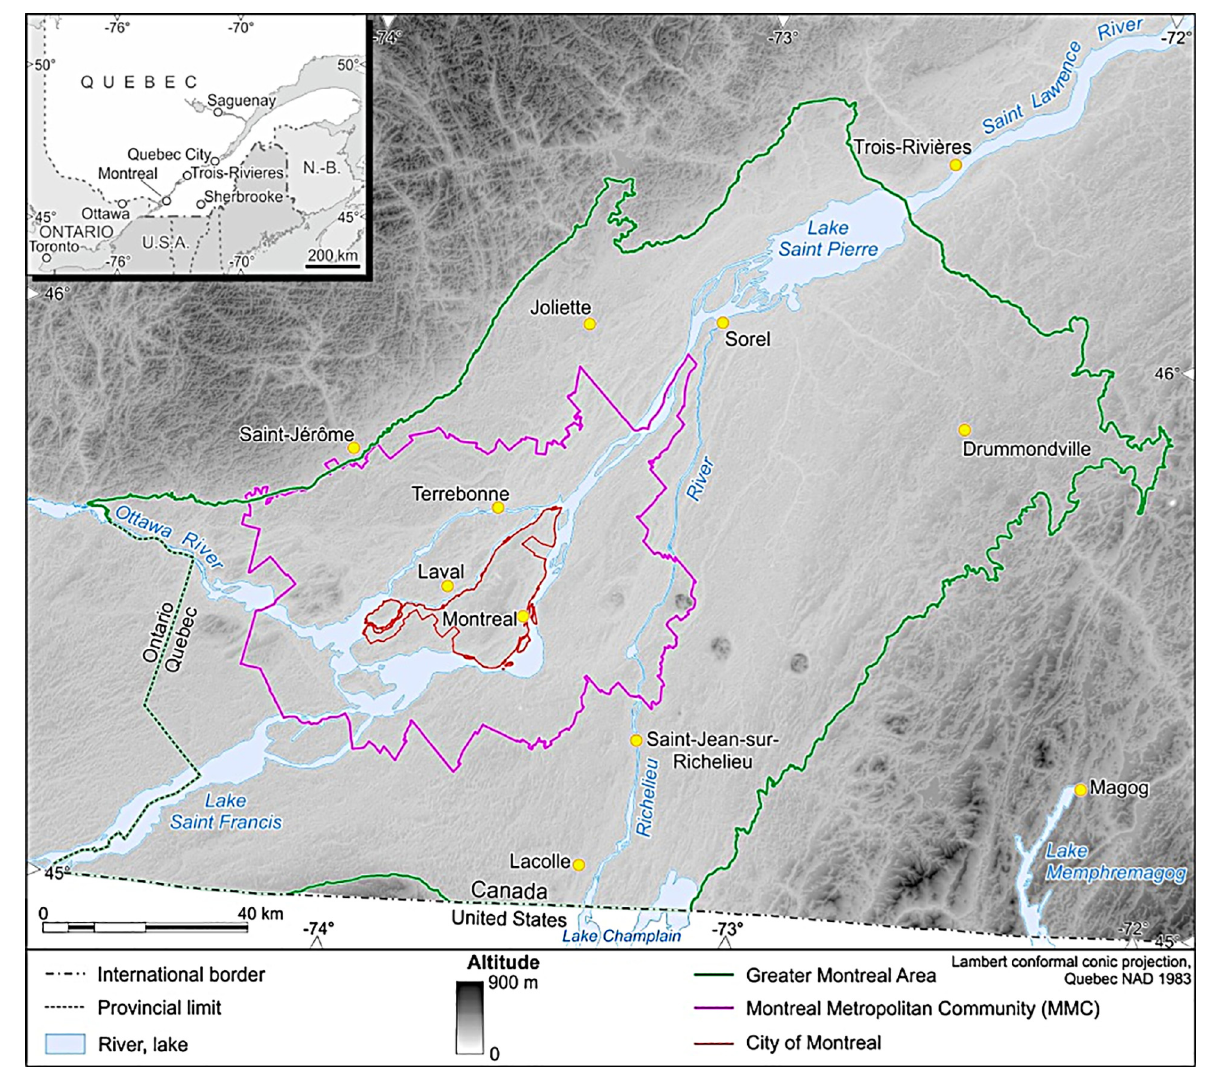
Fig 1. Location of the study